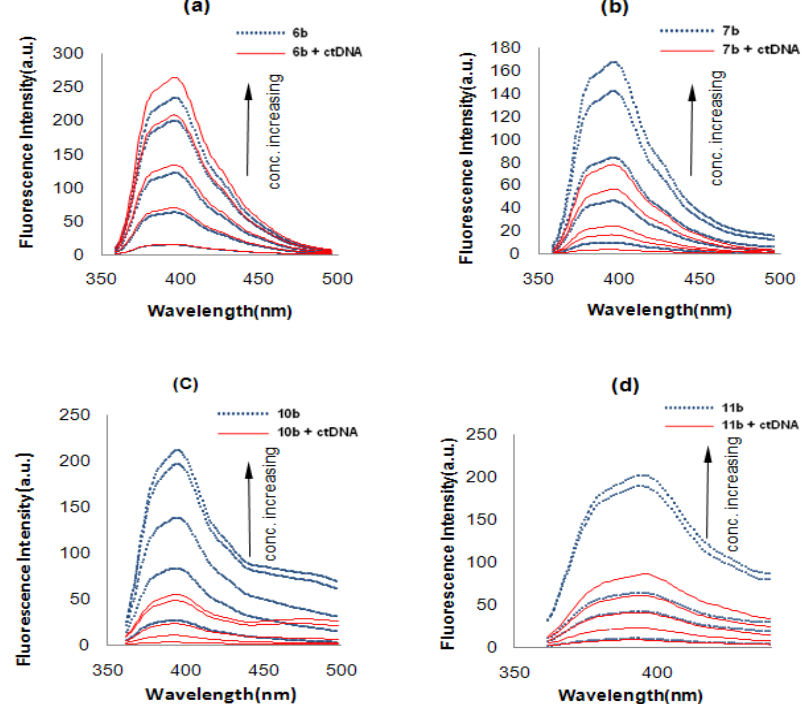
Figure 3. Fluorescence spectra of ( a ) 6b ( b ) 7b ( c ) 10b ( d ) 11b